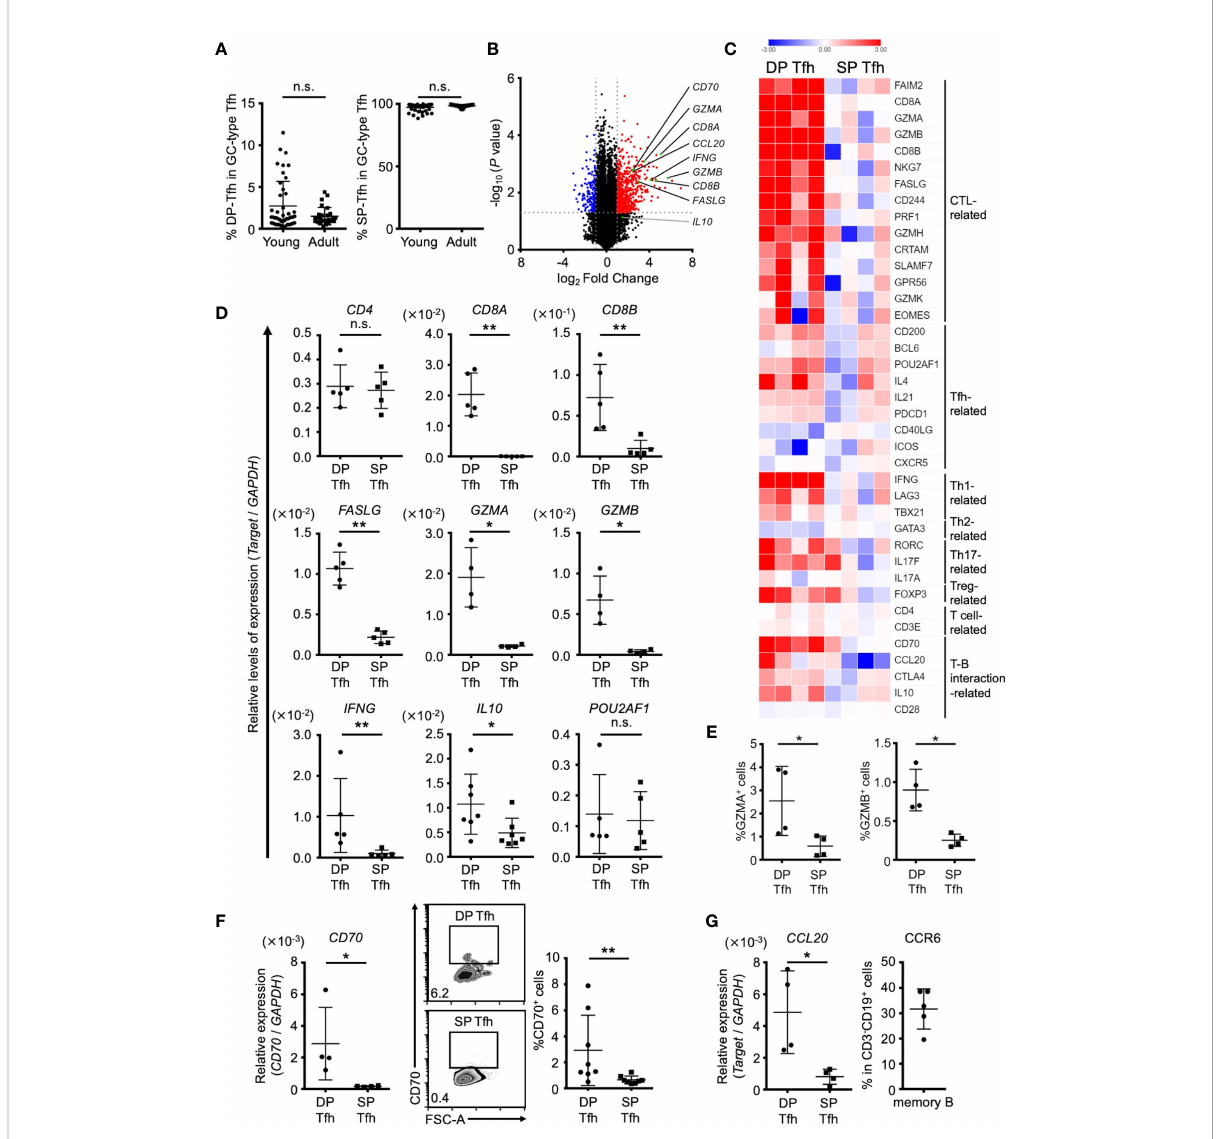
FIGURE 3 Different characteristics of DP-Tfh and SP-Tfh cells in tonsils. (A) Ratio of DP-Tfh cells (CD3 + CD4 + CD8 + CXCR5 hi PD-1 hi ) to total GC-type Tfh cells (CD3 + CD4 + CXCR5 hi PD-1 hi ) and ratio of SP-Tfh cells (CD3 + CD4 + CD8 - CXCR5 hi PD-1 hi ) to total GC-type Tfh cells in young (n = 44) and adult (n = 27) tonsils assessed by fl ow cytometry are shown in the left and right, respectively. (B) Volcano plot showing differentially expressed genes ( p < 0.05) with more than two-fold expression in DP-Tfh cells versus SP-Tfh cells (CD3 + CD4 + CD8 - CXCR5 hi PD-1 hi ) derived from tonsils. The red and blue dots indicate the upregulated and downregulated genes, respectively, in DP-Tfh cells. Data were obtained from microarray analysis of four tonsil specimens in each experimental group studying DP-Tfh and SP-Tfh cells. (C) Heat map representing the relative abundances of transcripts identi fi ed in (B) for selected genes regulating helper CD4 + T cells and CTLs. Relative values of gene expression are indicated by color. (D) Relative levels of expression of genes in DP-Tfh and SP-Tfh cells of tonsils (n = 4-7) as indicated in (C) are shown assessed by RT-qPCR analysis. GAPDH was used as a control. (E) Expression levels of granzyme A (GZMA) and granzyme B (GZMB)-positive cells in the DP-Tfh and SP-Tfh cells of tonsils (n = 4) as assessed by fl ow cytometry. (F) Expression level of CD70 in DP-Tfh and SP-Tfh cells of tonsils (n = 4) as examined by RT-qPCR analysis (left). FACS analysis of CD70 expression in these cells (middle, representative pro fi les, and right). (G) Expression level of CCL20 in DP-Tfh and SP-Tfh cells of tonsils as examined by RT-qPCR analysis (tonsil, n = 4; left). Expression of the CCL20 receptor, CCR6, on memory B cells assessed by fl ow cytometry (tonsil, n = 5; right). Data in (A, D – G) were analyzed by the Mann – Whitney U